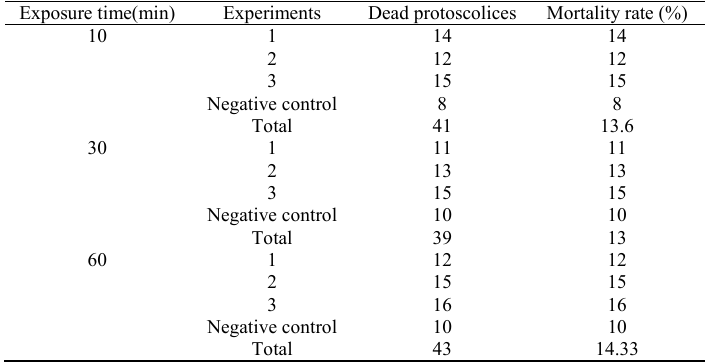
Table 2. Scolicidal effect of ZnO NPs at the 100 mg/ml concentration following various exposure times Exposure time(min)